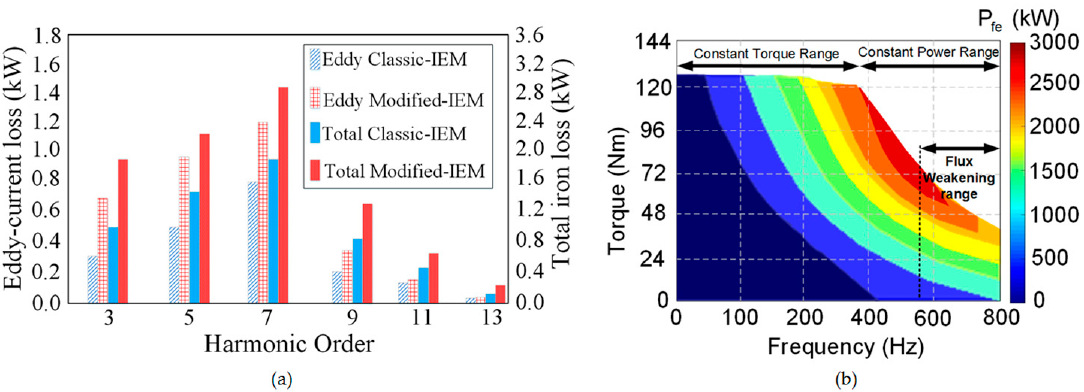
Figure 7 . Harmonic spectra and total iron loss prediction using classic and modified IEM-Formula during flux weakening operation time (FWOT), where: ( a ) existing dominant harmonics on total iron loss and specially eddy current loss; ( b ) presentation of the torque-frequency-power loss by the modified IEM-Formula .